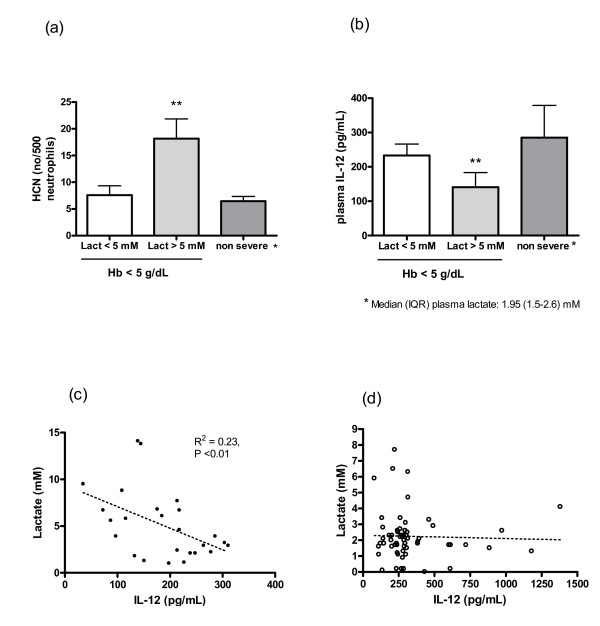
Association of plasma lactate levels with HCN (a) and plasma IL-12 concentration (b) in children with severe malaria (N = 26) and non-severe malarial anaemia controls (N = 60). Scatter plot of the association of lactate concentration and IL-12 in children with severe anaemia and malaria (c) and non-severely anaemic controls with malaria (d). Bars show mean and error bars standard error of the mean. ** P < 0.01 (Mann-Whitney test). R2 = coefficient of determination.